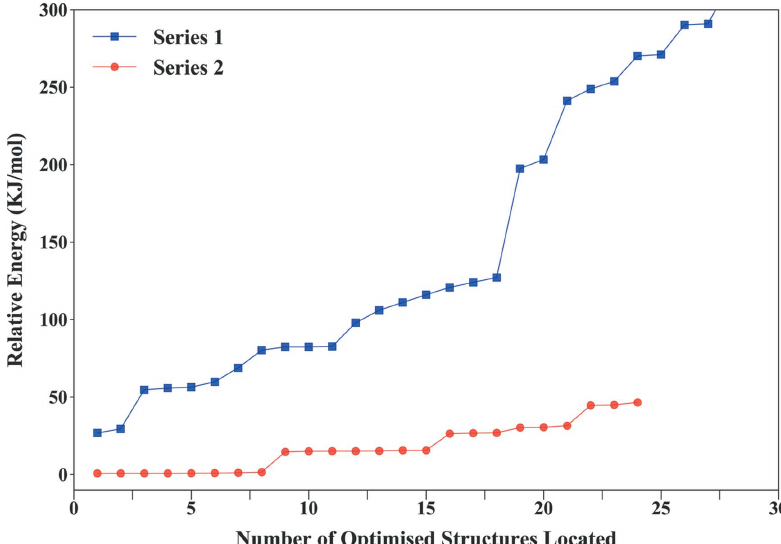
Figure 4 Structure-ranking plots obtained from the two AIRSS runs. Series 1 is shown in blue, where all 36 hydrogen atoms were randomly located on all water molecules; Series 2 is shown in red, where random hydrogen atoms were placed on free water molecules only.